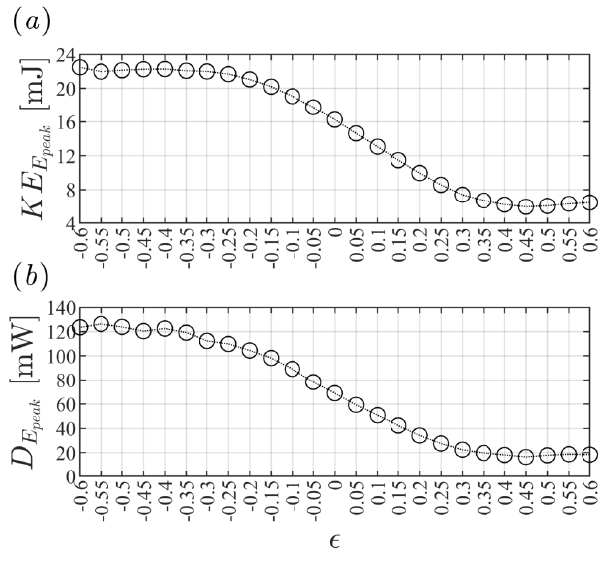
Figure 4. Graphical representation of ( a ) diastolic peak values of KE and ( b ) D for different valve